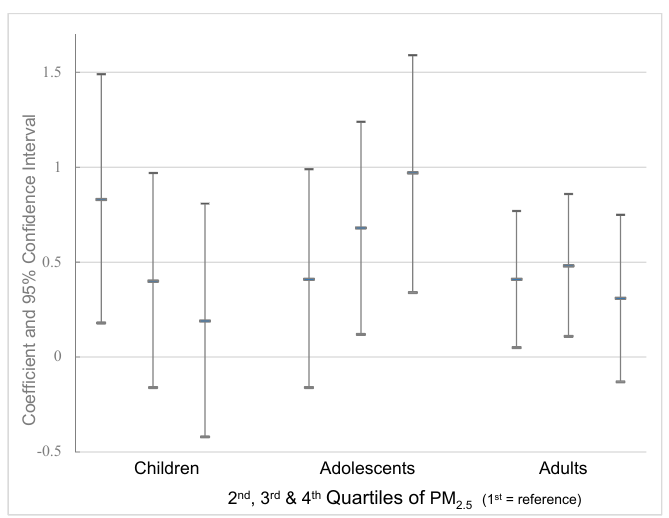
Figure 1. Associations between quartiles of PM 2.5 (annual mean) and obesity in three age groups, ENSANUT 2012.